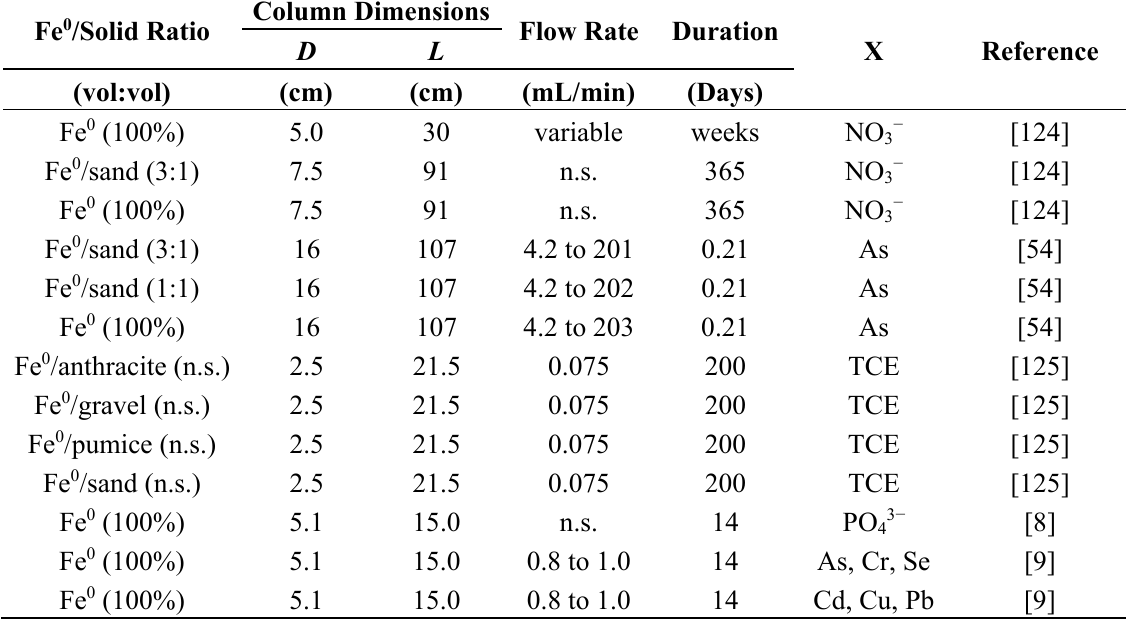
Table 1. Selected operational conditions of column studies presented as examples